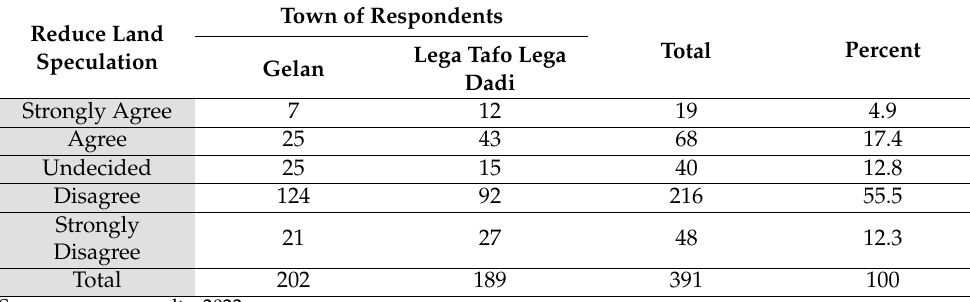
Table 4. The response rates of respondents on land